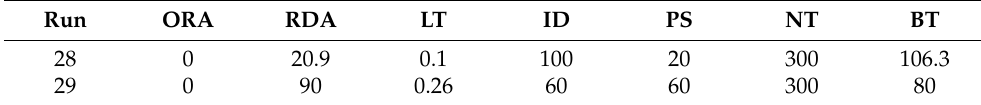
Figure 13. Three-dimensional surface graphs: ( a ) part weight (g) vs. ID (%) and ORA (deg), ( b ) com- pression strength (MPa) vs. ID (%) and ORA (deg), ( c ) energy (MJ) vs. LT (mm) and ID (%), ( d ) printing time (s) vs. LT (mm) and PS (mm/s), ( e ) compression strength (MPa) vs. RDA (deg) and LT (mm), ( f ) energy (MJ) vs. ORA (deg) and RDA (deg). Table 5. Control parameters for the confirmation runs.